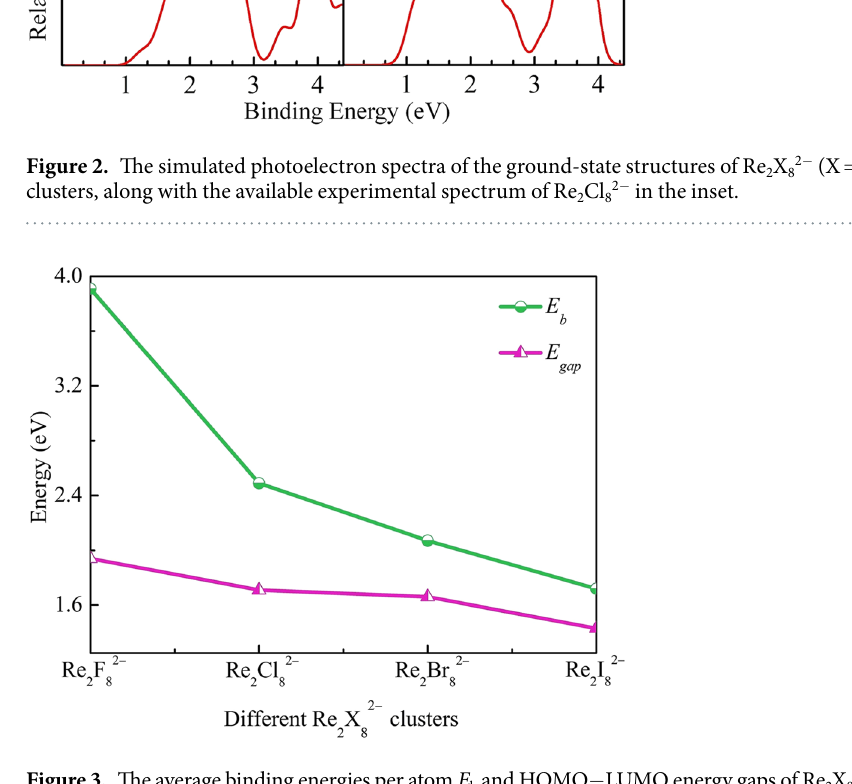
Figure 3. The average binding energies per atom E b and HOMO − LUMO energy gaps of Re 2 X 82 − (X = F, Cl, Br,